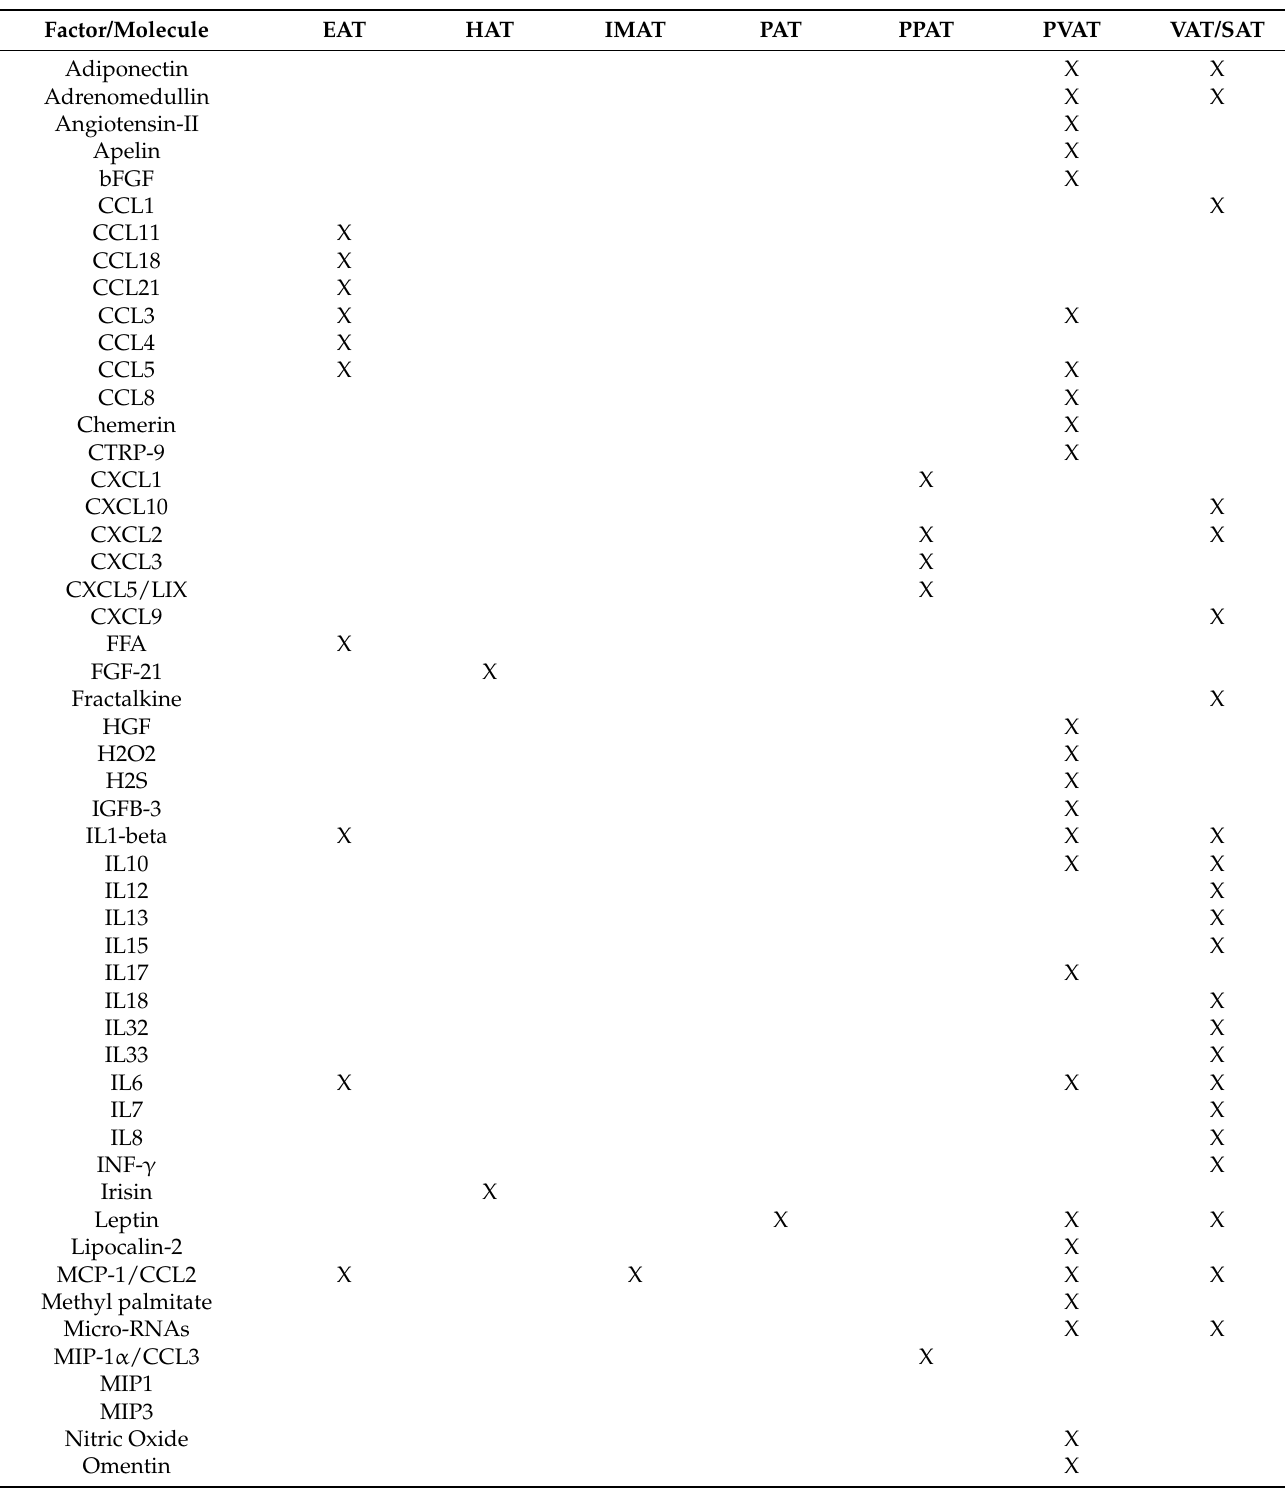
Table 1. Diffusible factors synthesized and released by adipose tissues in obese subjects 1